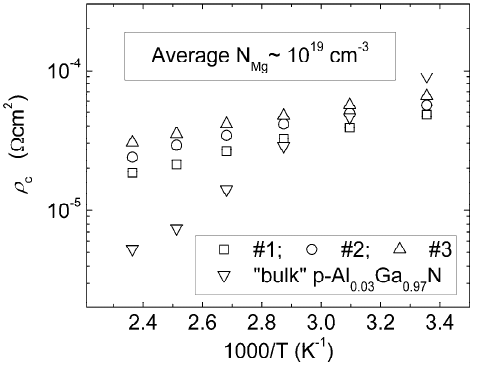
Figure 8. Specific contact resistances of Mg-doped AlN/Al x Ga 1 − x N SPSLs (y ave ~0.7) and Al 0.03 Ga 0.97 N epitaxial layer at different temperatures.